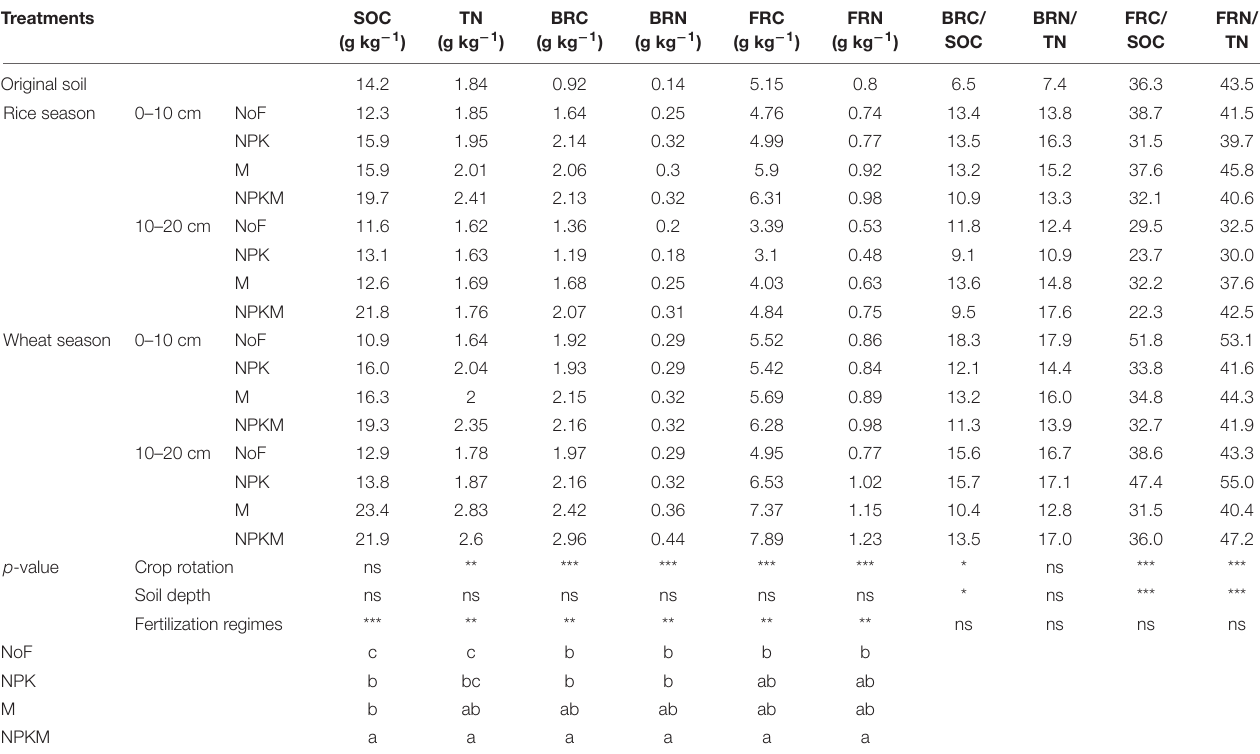
TABLE 2 | The average contents and ratios of C and N in soils and microbial residues.